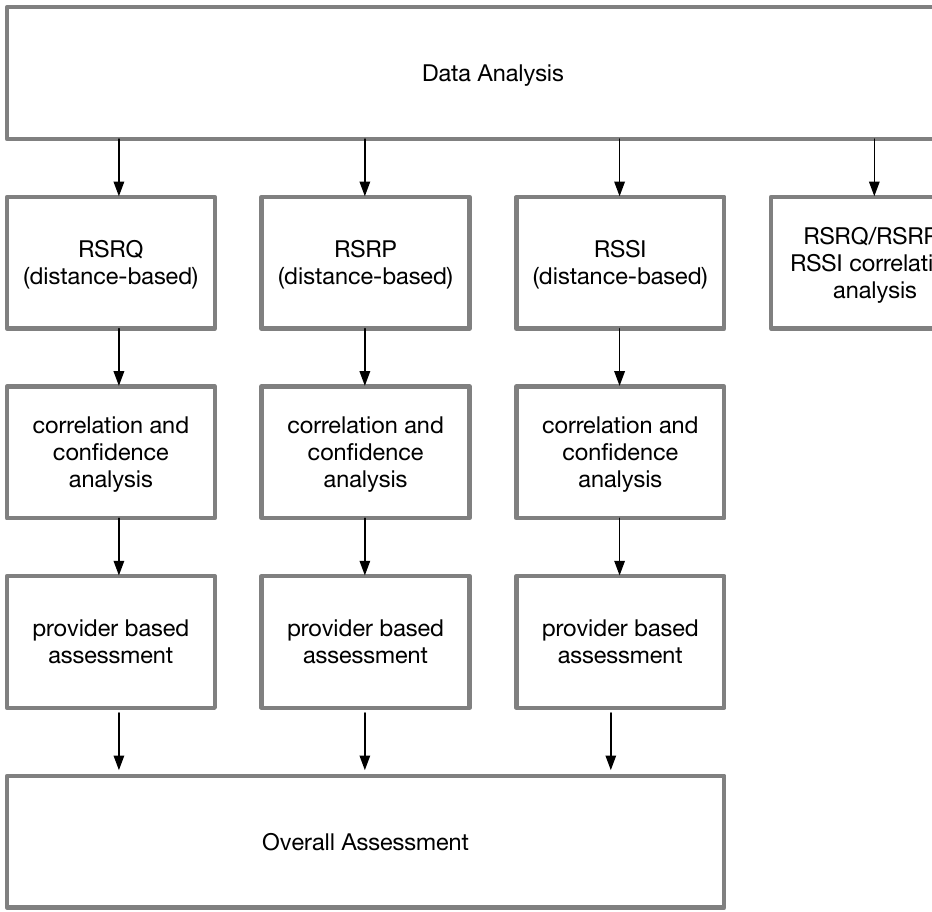
Figure 4. The data assessments performed within this